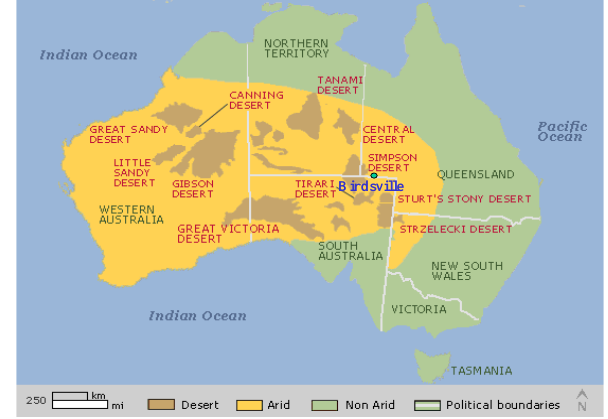
Fig. 1. Map of Australia showing Birdsville